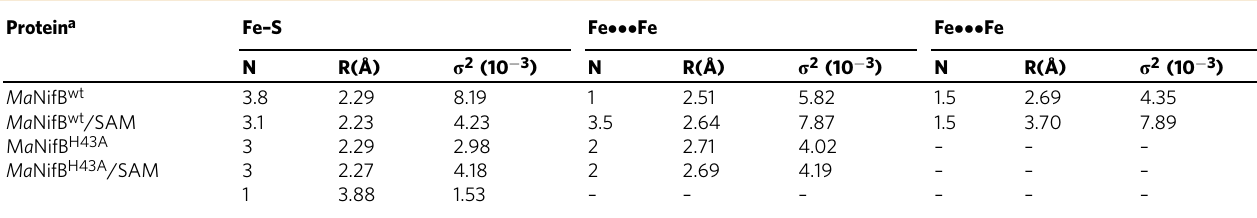
Table 2 Best fi ts of the Fe K-edge EXAFS data. Protein